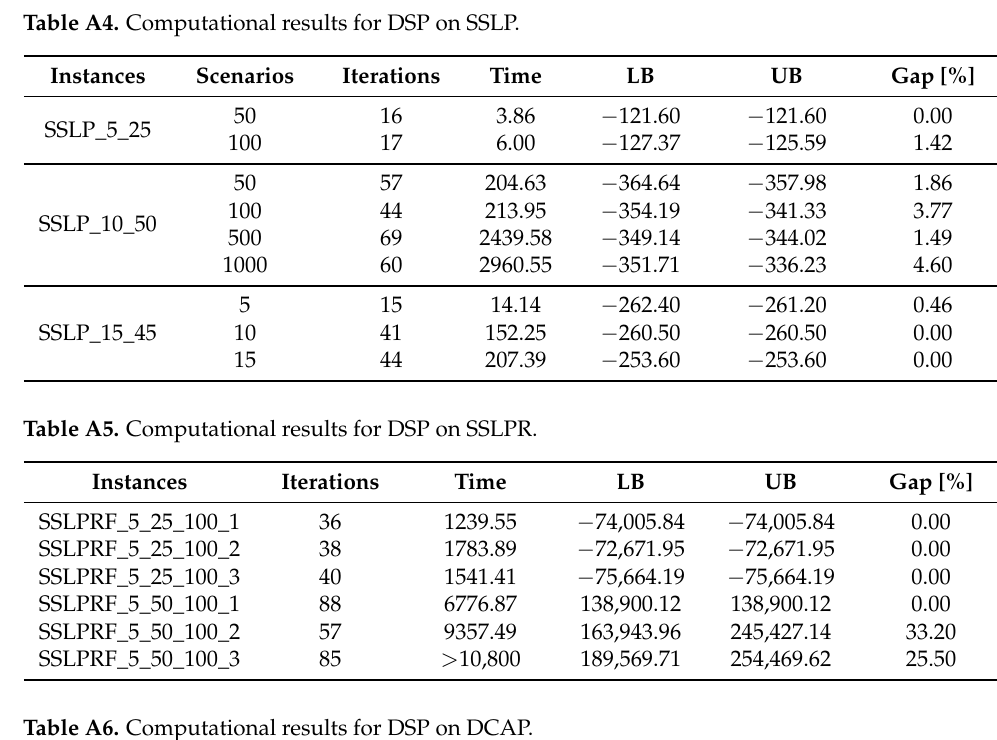
Table A6. Computational results for DSP on